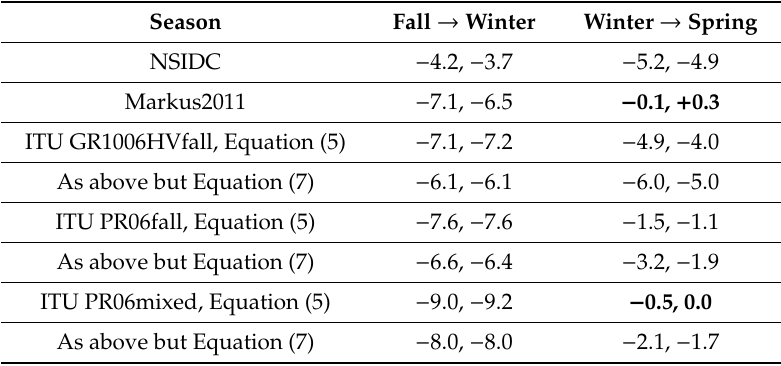
Table 5. The change in the mean snow depth from fall to winter and from winter to spring (in centimeters) for NSIDC, Markus2011 and the ITU implementations shown in Table 4. The first and second value per cell are obtained using a 2 m-air temperature threshold of − 2 ◦ C and − 10 ◦ C, respectively. Markus2011 and ITU PR06mixed are highlighted in bold font as these provide the smallest winter-to-spring